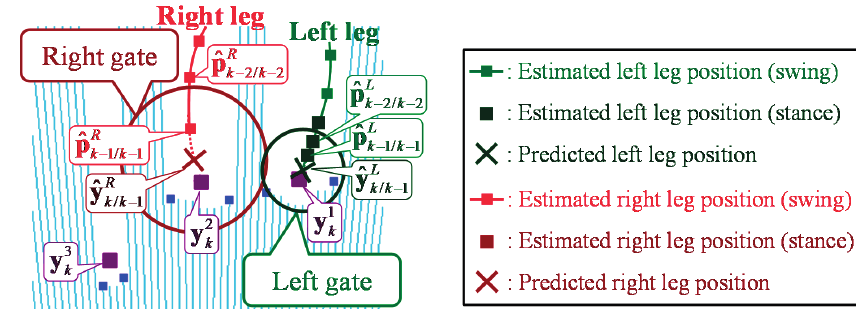
Figure 8. Data association with